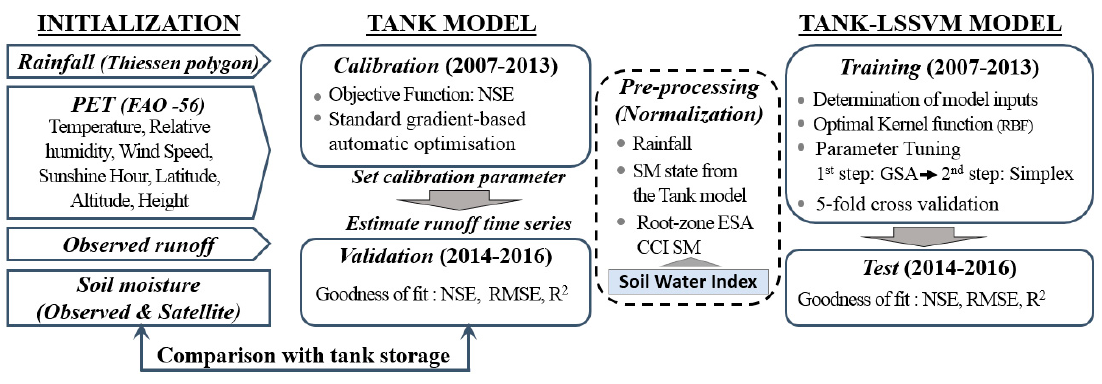
Figure 4. Schematic representation of the Tank-least squared support vector machine (LSSVM) modeling process. modeling